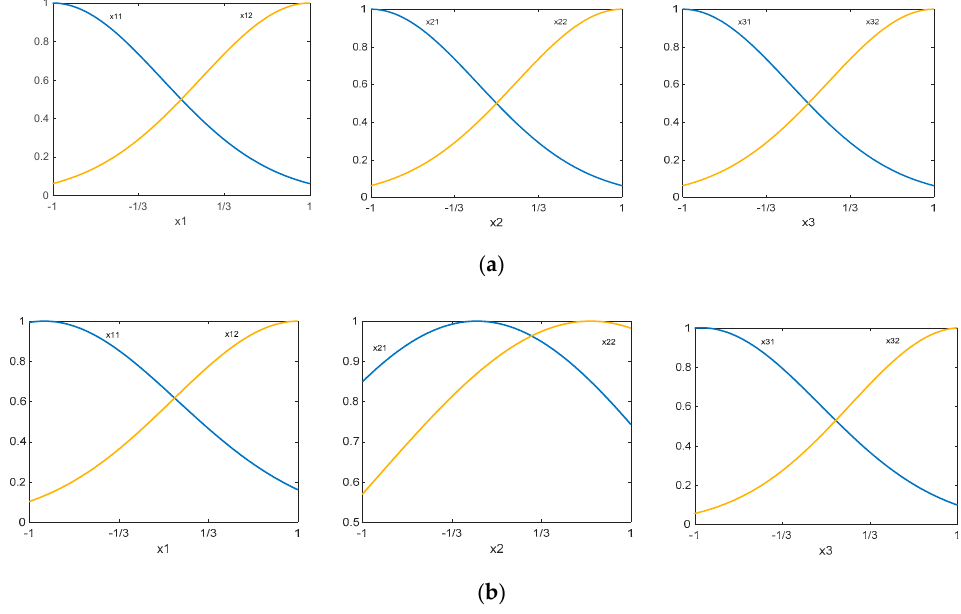
Figure 20. Membership functions for modeling type 1 function ( f 1 ) ( a ) before the ANFIS and ( b ) after the ANFIS.